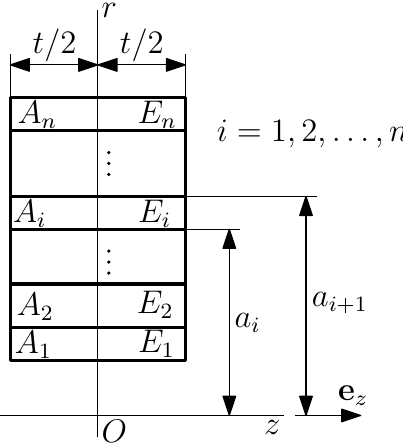
Figure 40: Cross section of multilayered composite